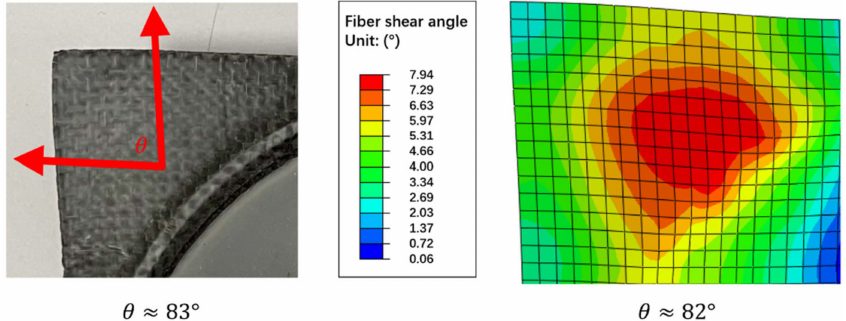
Figure 22. Comparison of fiber